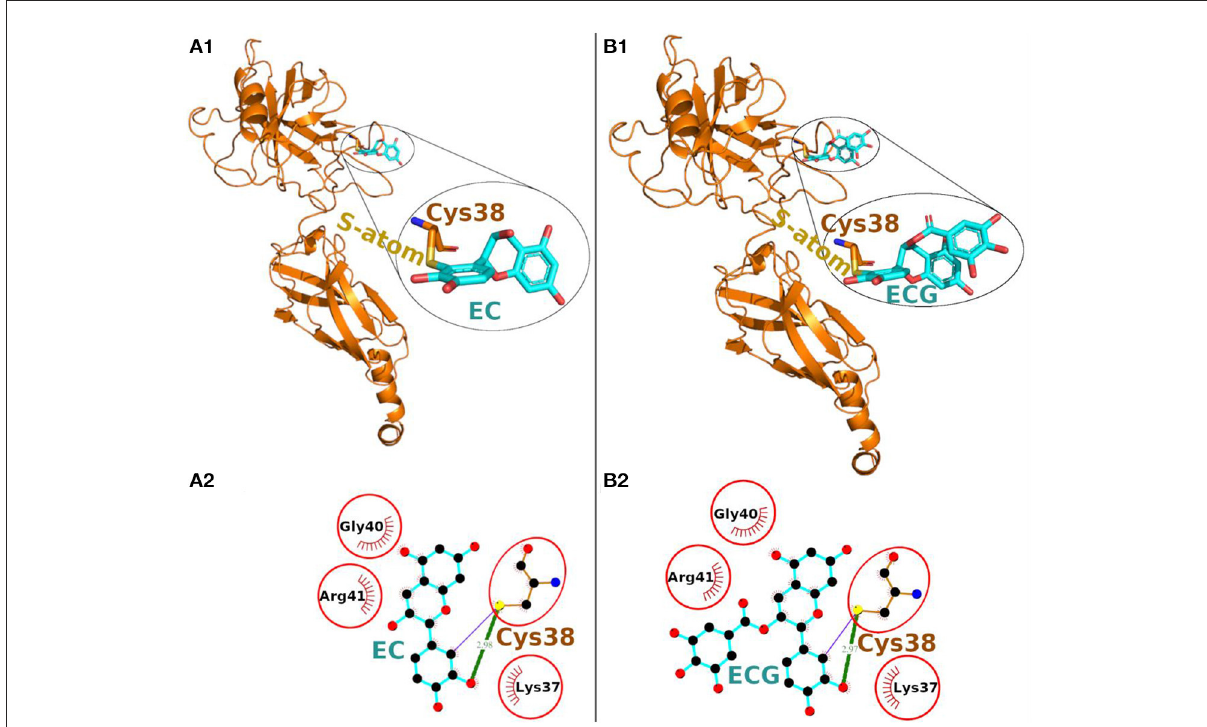
FIGURE2 Covalent docking of EC (A) and ECG (B) to NF- κ B p65. (A1, B1) The protein is shown in ribbon representation colored orange with Cys adducts. In inset, the Cys adduct is zoomed and shown in sticks representation with Cys-38 backbone colored orange, S-atom colored yellow and EC and ECG backbones in cyan. The O-atoms and N-atoms are colored in red and blue colors, respectively. (A2, B2) Ligand-protein interaction plots. The EC and ECG with Cys-38 are shown with backbone color cyan and orange, respectively with balls as atoms. The color of the balls decides atom types as the black color for C-atoms, the blue for N-atoms, red for O-atoms and yellow for S-atoms, respectively. The covalent bond with S-atom of Cys-38 is shown as purple line and the hydrogen bond as green line with bond length in Å. The residues forming non-bonded contacts are shown as red comb like structure. The residues found common to the interacting residues of EC and ECG are encircled.